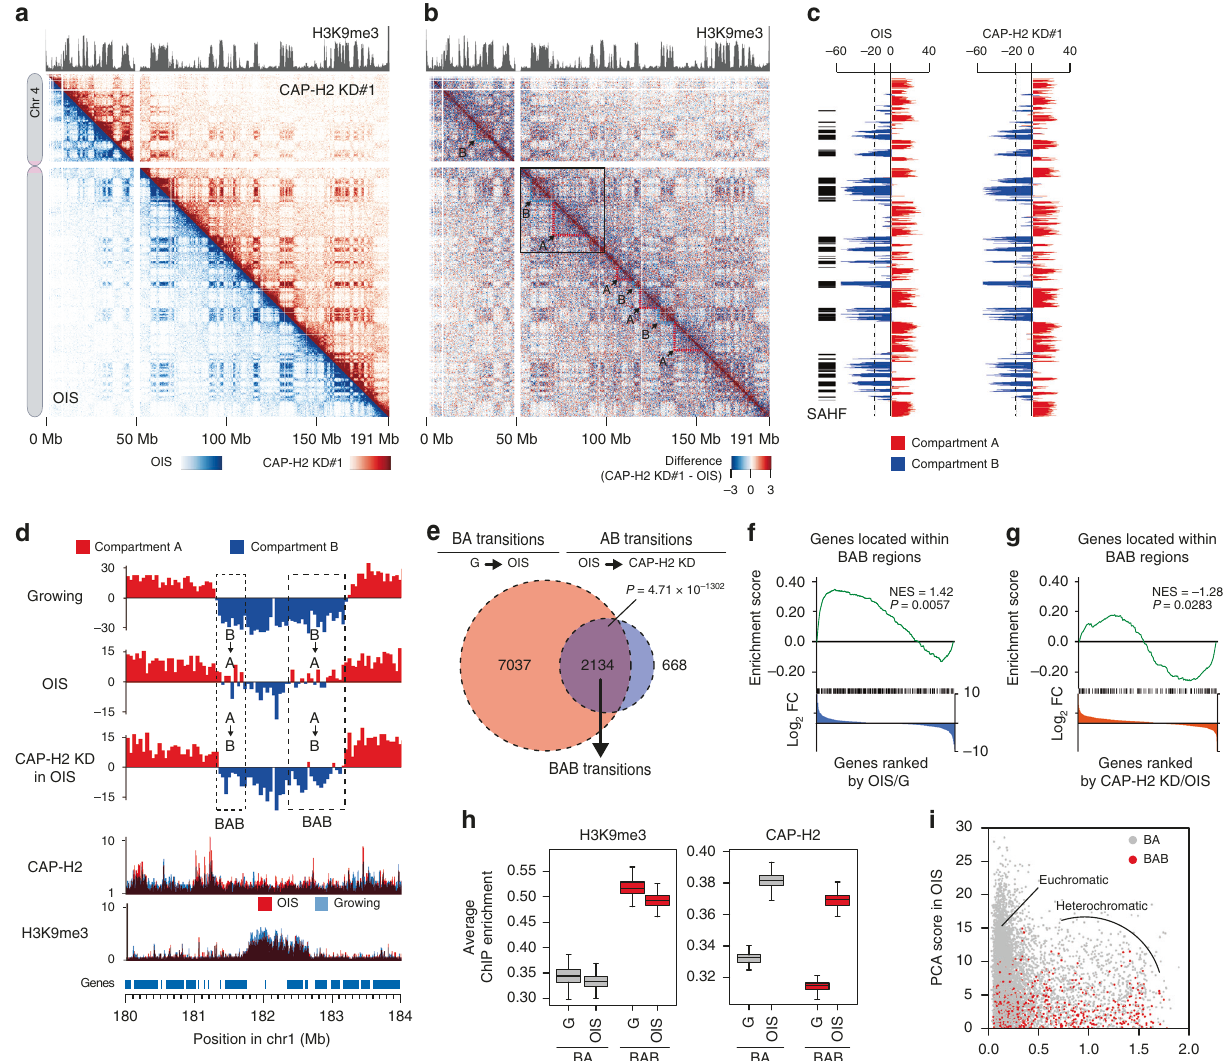
Fig. 9 Effects of CAP-H2 depletion on A/B compartmental organizations. a Contact maps for chromosome 4 in CAP-H2 KD (#1) (top right) and OIS (bottom left) cells at 200 kb resolution. Cells were prepared as in Fig. 7a. Histone H3K9me3 ChIP-seq data (GEO accession#, GSE38448) are shown at top. b Difference of contact probabilities for the data shown in panel a . Red and blue dots indicate that contact probabilities were higher in CAP-H2 KD and OIS cells, respectively. Red and blue dotted lines represent reduced and elevated contact scores in A and B compartments, respectively. The 50 Mb genomic region indicated by open box is enlarged in Fig. 10b. c PCA scores in OIS and CAP-H2 KD cells plotted along chromosome 4. SAHF were de fi ned as genomic regions with PCA scores < − 20; locations are indicated by black bars at left. d An example of the BAB compartmental transitions. The BAB transitions indicate regions that underwent BA transitions upon OIS and AB transitions upon CAP-H2 KD. PCA scores in the indicated cell types are plotted along a 4 Mb region in chromosome 1. CAP-H2 and H3K9me3 ChIP-seq data are shown beneath. e Overlap of genomic regions (40 kb bins) undergoing BA transitions upon OIS and AB transitions upon CAP-H2 KD (hypergeometric distribution test). f GSEA of genes ( n = 395) located at genomic regions undergoing BAB transitions. Human genes were ranked by expression fold changes (FC), where expression levels of genes in OIS cells were divided by those in growing cells. g GSEA of genes ( n = 232) located at genomic regions undergoing BAB transitions and upregulated upon OIS. Human genes were ranked as expression levels in CAP-H2 KD cells were divided by those in OIS cells. h Average ChIP-seq enrichment of CAP-H2 and H3K9me3 at BA and BAB regions. Genomic regions that belonged to the compartmental categories (BA and BAB) were analyzed as in Fig. 4c. For boxplots central bar represents the median with boxes indicating the upper and lower quartiles, and whiskers extend to the data points, which are no more than 1.5× the interquartile range from the box. i PCA scores of 40 kb bins from BA (gray) or BAB (red) genomic regions plotted against H3K9me3 ChIP-seq enrichment in OIS